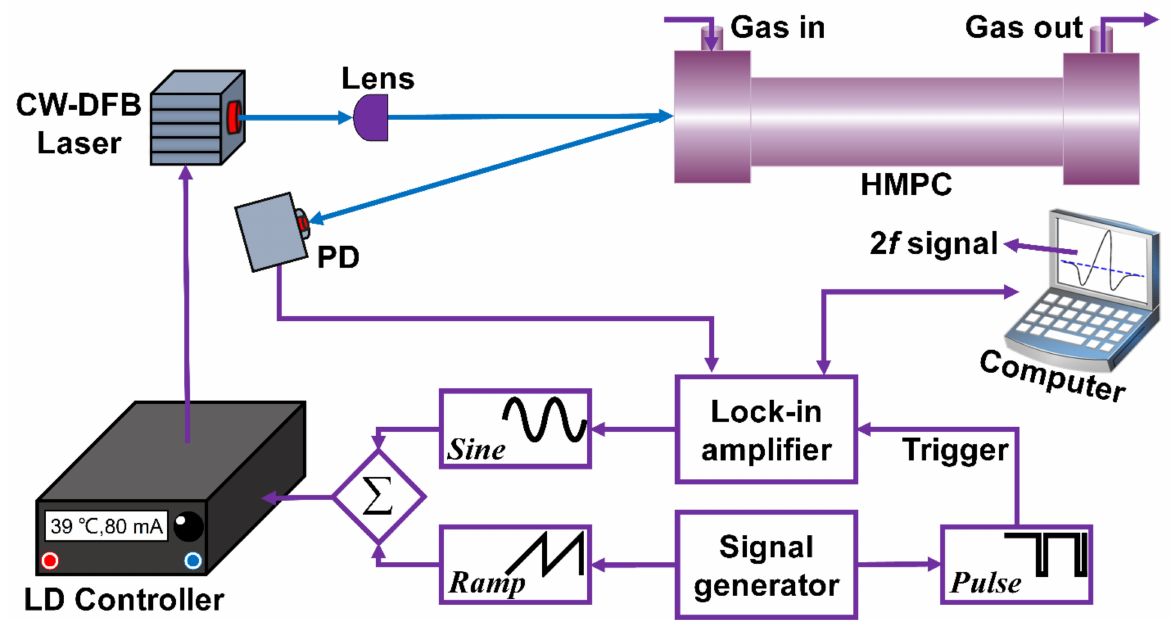
Figure 2. A schematic diagram of the H 2 -TDLAS sensing system.